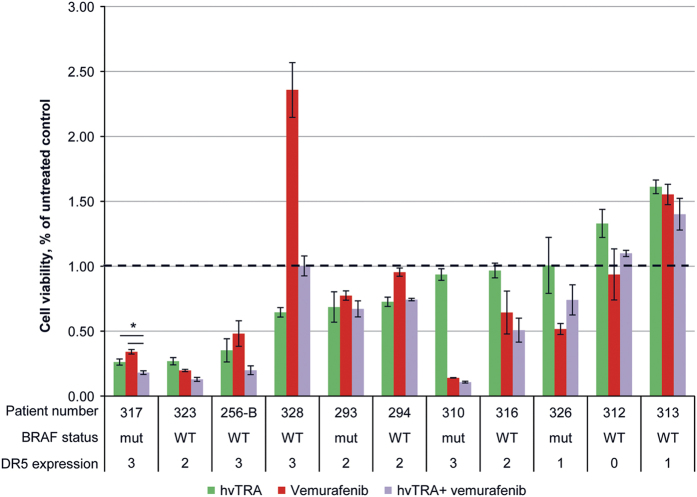
Sensitivity to hvTRA, vemurafenib and the combination in patient biopsies. Eleven biopsies from lymph node metastases from melanoma patients were made into single-cell suspensions, and seeded in 96-well round-bottom plates and exposed to hvTRA (5 μg/ml), vemurafenib (5 μM) or the combination. Cell viability was measured after 120 h using CellTiter-Glo Luminescent assay. Three technical replicates were performed, and the error bars represent±S.D. The luminescent signal from untreated control cells from each patient sample were set to 1, indicated by the dotted line. For DR5 expression 0; not expressed, 1; 0–10% of the cells express DR5, 2; 10–50% of the cells express DR5, 3; >50% of the cells express DR5. Patient biopsies 294 and 328 have mutated NRAS. *P<0.05.